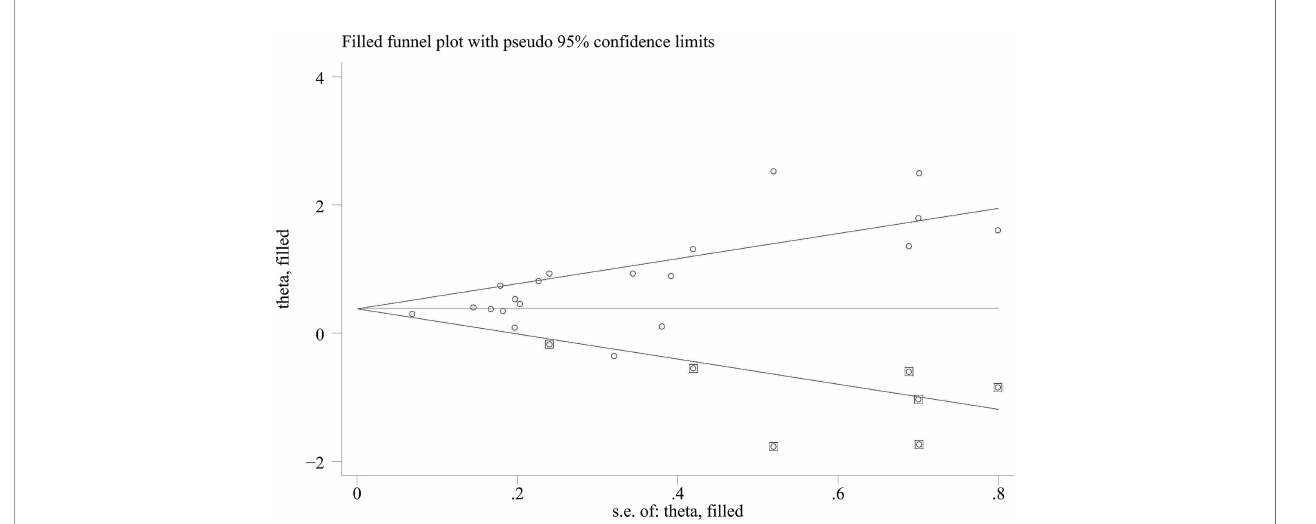
FIGURE 4 | Trimming chart of multivariate analysis outcomes of baseline CRP levels and